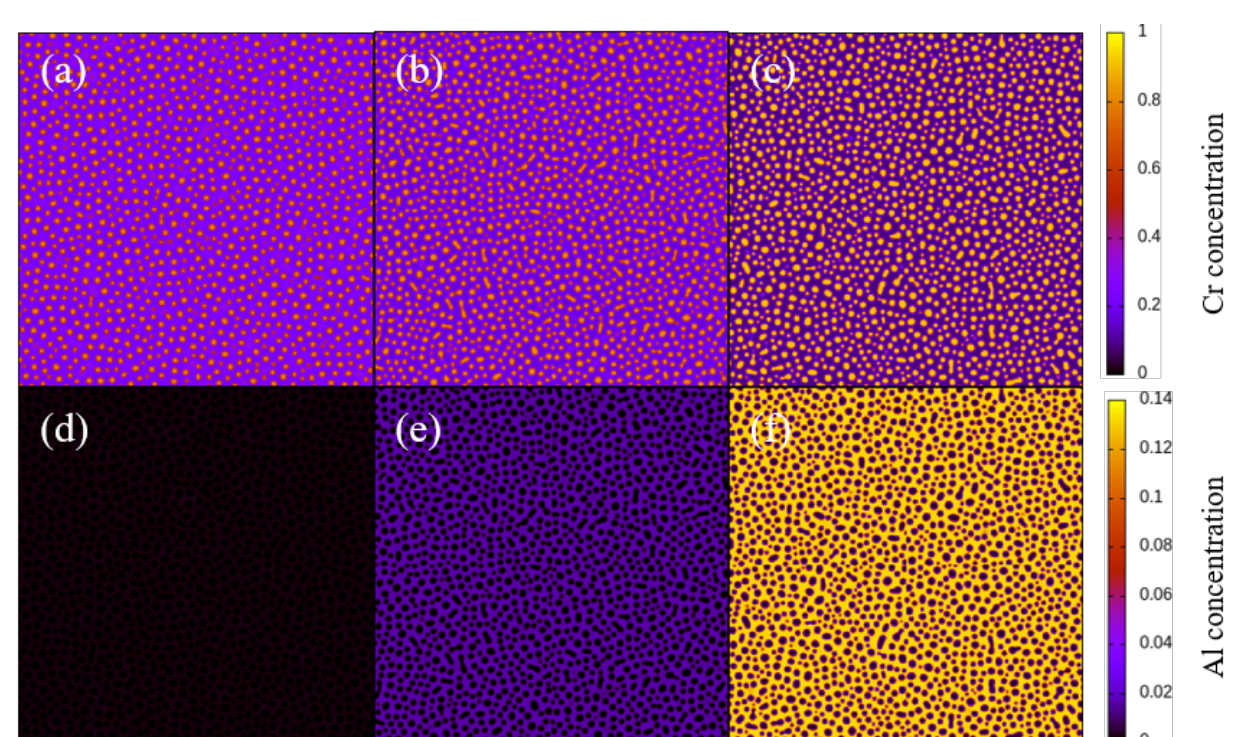
Figure 8. Plots of the Cr or Al concentration at t ∗ = 5.0 × 10 6 when the average Cr concentration was 35% and the average Al concentration was ( a , d ) 0.1%, ( b , e ) 1%, and ( c , f ) 9%. Cases ( a – c ) are plots of the Cr concentration field and cases ( d – f ) are plots of the Al concentration field.